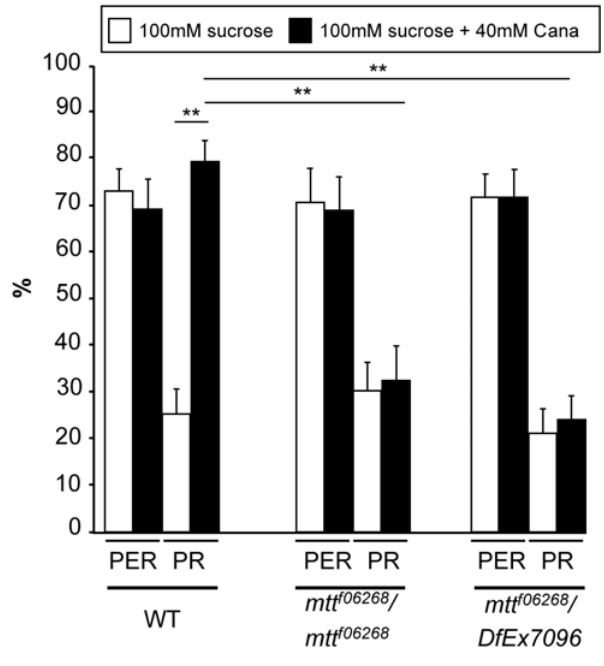
Figure 6. L -Canavanine does not affect the occurrence of PER, but induces a DmXR-dependent retraction of the proboscis after the reflex. For behavioral analyses, the solutions (100 mM sucrose in white and 100 mM sucrose + 40 mM L -canavanine in black) were put in contact with the leg tarsi during the 5-s assay. L -Canavanine (Cana) does not affect the percentage of proboscis extension reflex (PER) in WT and mtt mutant ( mtt f06268 /mtt f06268 and mtt f06268 /DfEx7096 ) flies. After the PER response, L -canavanine triggers the proboscis retraction (PR) in WT, but not in mtt mutant flies. Error bars indicate SEM. Asterisks indicate significant differences by t-test ( p ,